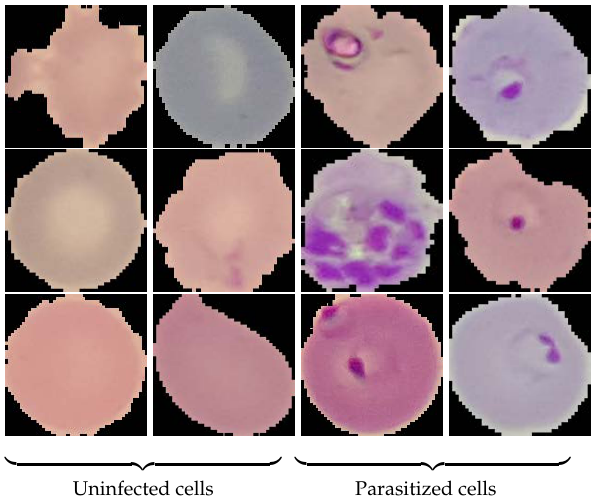
Figure 6. Sample images of parasitized (infected) and uninfected red blood cells from NIH Malaria dataset [54].